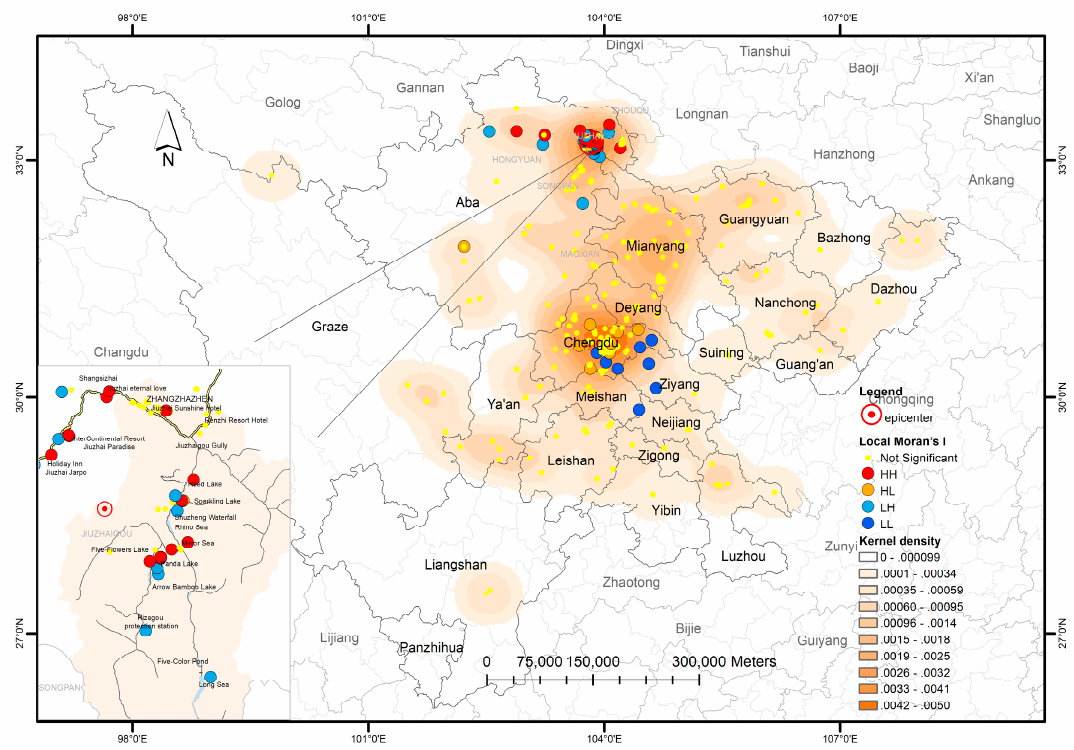
Figure 5. 24-h Anselin’s Local Moran’s I and kernel density of microblogs.